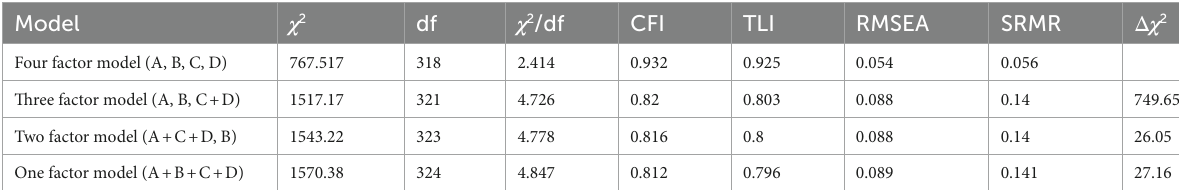
TABLE 1 The results of the confirmatory factor analysis. Model